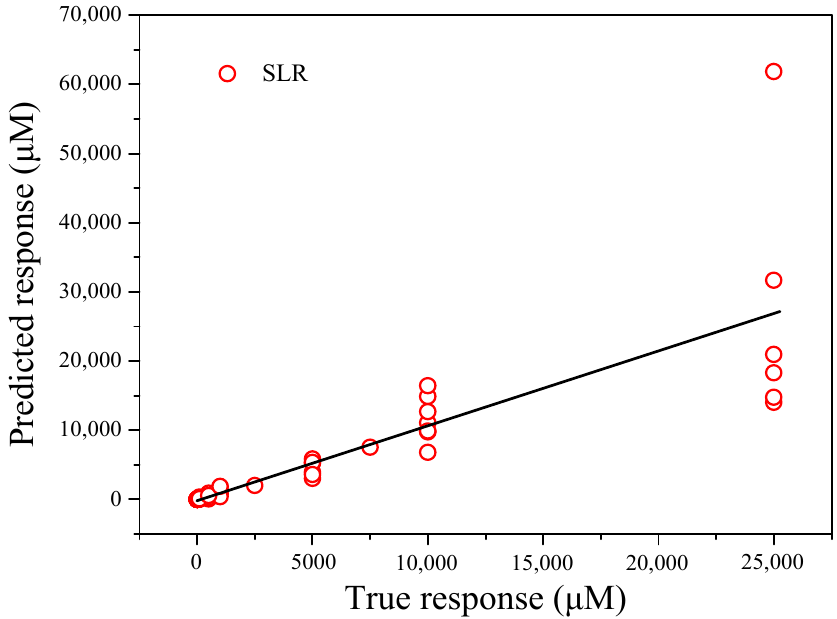
Figure 11. Predicted Ca 2+ concentrations obtained by stepwise linear regression vs. the actual Ca 2+